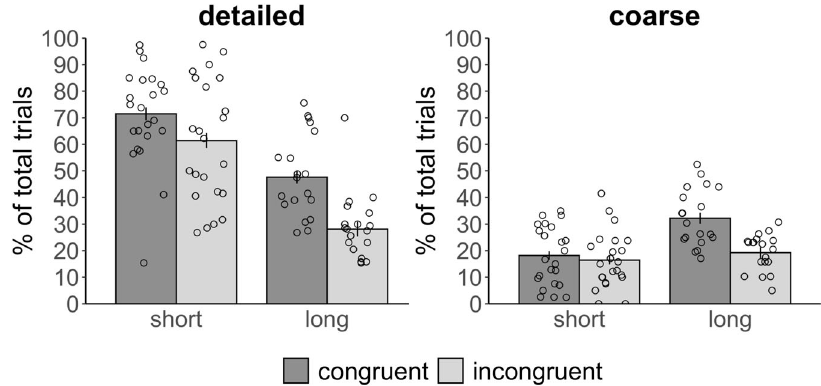
Fig. 2 | Quality of memory for congruent and incongruent associations over time. We examined the percent of total congruent and incongruent trials that were correctly retrieved as a function of memory granularity. Memories were considered coarse if participants retrieved the correct context an object had been paired with but not the speci fi c scene and were considered detailed if they